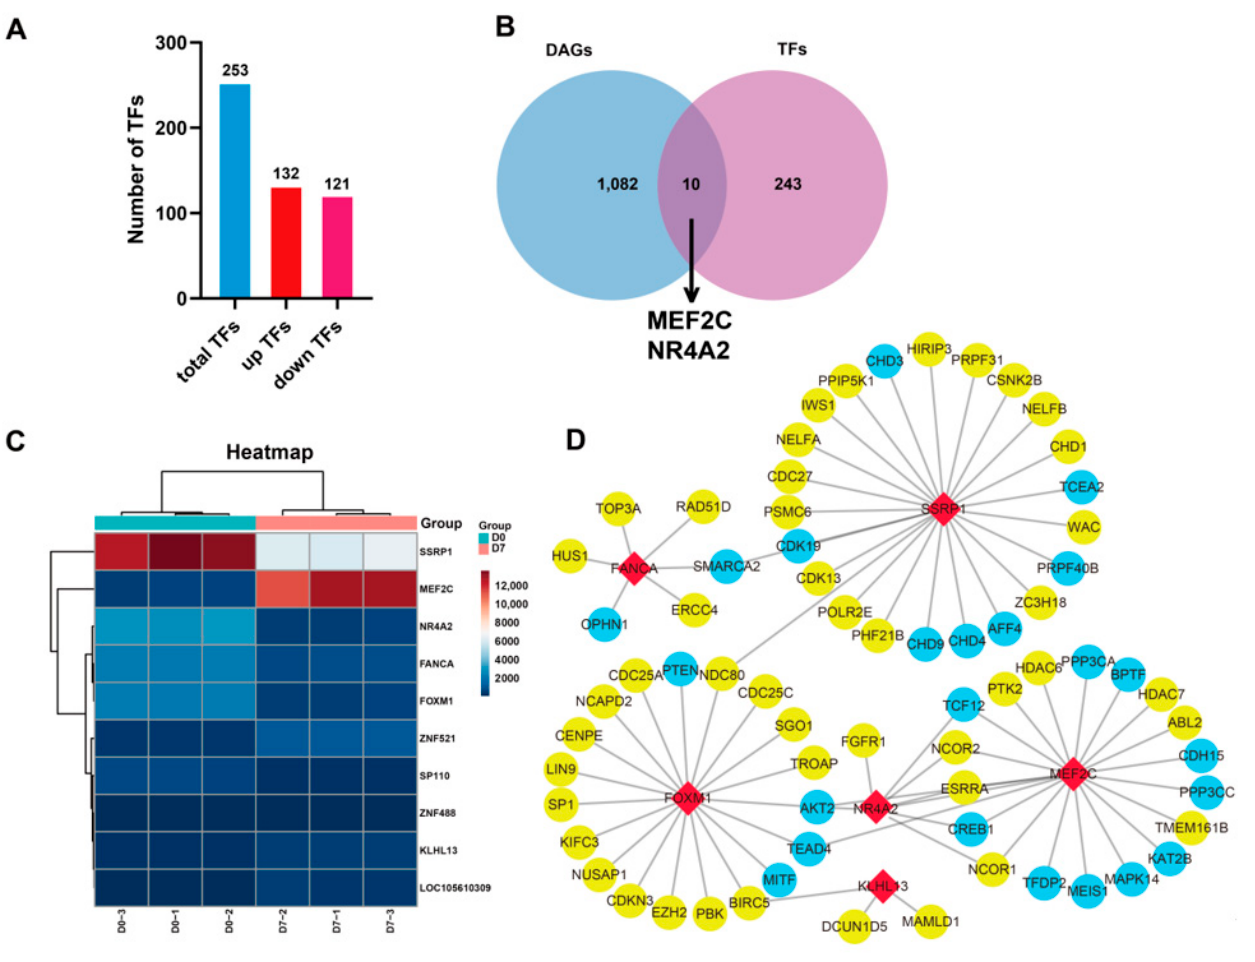
Figure 6. Transcription factor analysis of DEGs in SMSCs between the myoblasts and myotubes. ( A ) The number of TFs in upregulated and downregulated TFs (|log2 Fold Change| > 1). ( B ) Venn diagram of DAGs and TFs. ( C ) Heatmap of the nine transcription factors. ( D ) The protein–protein analysis of DAGs and TFs with differentially expressed genes split into two groups. Red, transcription factor; blue, upregulated genes; yellow, downregulated genes.